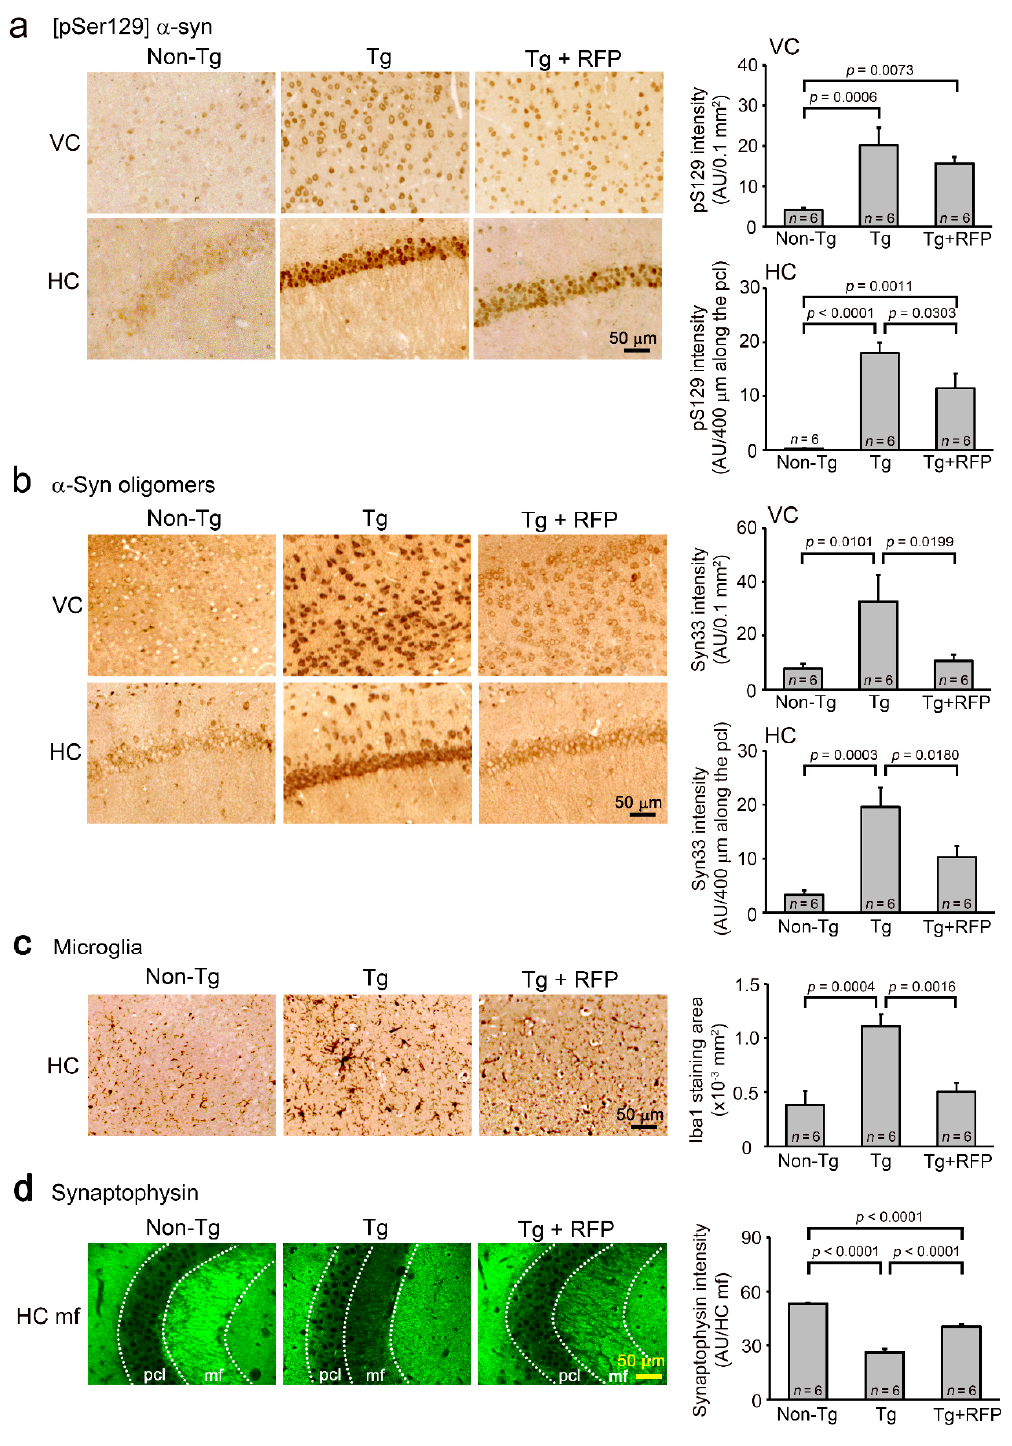
Figure 5. Effects of intranasal rifampicin on α -synuclein pathologies in Tg mice. After the second Morris water maze test, brain sections were prepared and stained. The levels of [pSer129] α -synuclein ( a ) and α -synuclein oligomers ( b ) in the visual cortex (VC) and hippocampus (HC) were quantified. ( a , b ) [pSer129] α -synuclein was significantly reduced in the HC and to some extent in the VC by rifampicin treatment, while α -synuclein oligomers were significantly decreased in both regions. Syn33 is an antibody to α -synuclein oligomers. ( c ) The levels of activated microglia were quantified in the HC. Rifampicin significantly attenuated microglial activation. ( d ) Synaptophysin levels in hippocampal mossy fibers (HC mf) were measured using the intensity in the pyramidal cell layer (pcl) as a control. Rifampicin significantly recovered the synapse level in Tg mice. RFP, rifampicin; AU, arbitrary